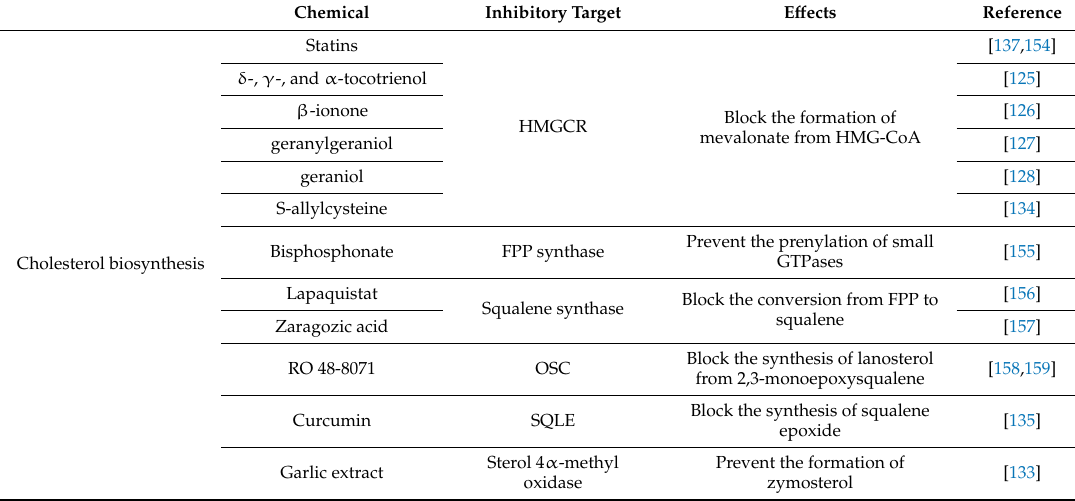
Table 2. Therapeutic targets of cholesterol